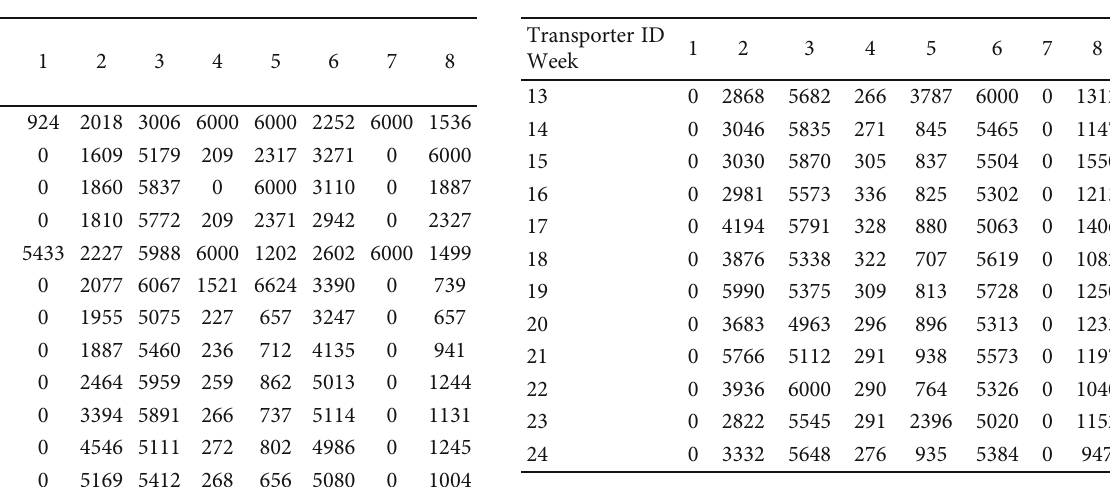
Table 4: Table of suppliers to transporters (1-12 weeks). Table 5: Table of suppliers to transporters (13-24